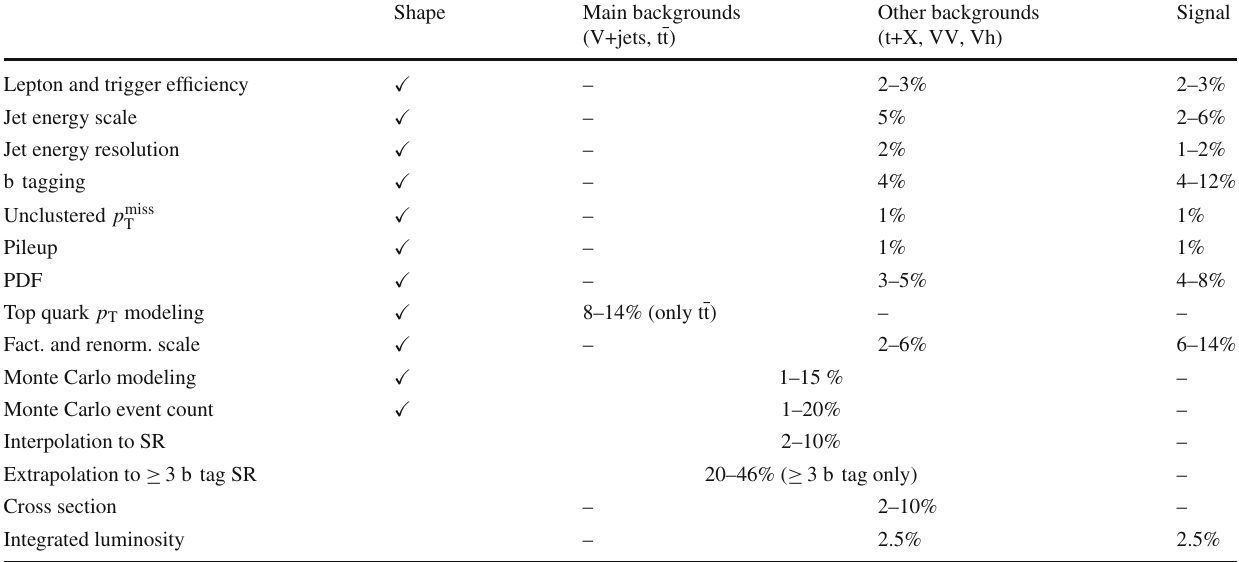
Table 2 Summary of statistical and systematic uncertainties for backgrounds and signal. The uncertainties marked with (cid:3) are also propagated to the m Zh and m T distributions Zh